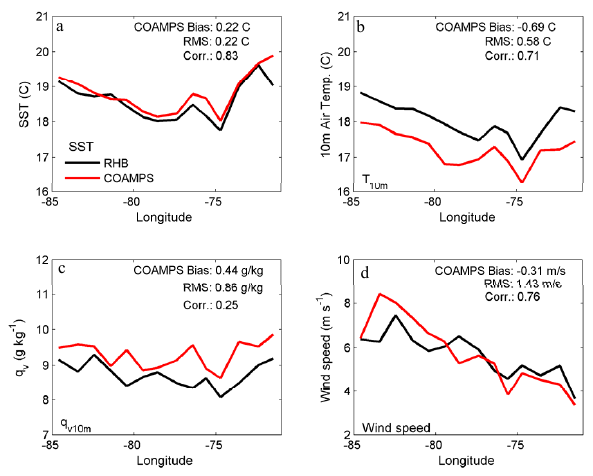
Fig. 11. Comparisons of longitudinal variations at 20° S of (a) SST, (b) T 10m , (c) q v10m , and (d) 10-m wind speed between the COAMPS forecasts and the RHB observations. All the plots are produced by averaging each variable into 1-degree longitude bins using the corresponding RHB and COAMPS data. The overall statistics (bias, RMS difference, and correlation coefficient) for the COAMPS-RHB comparisons are also displayed in each panel.